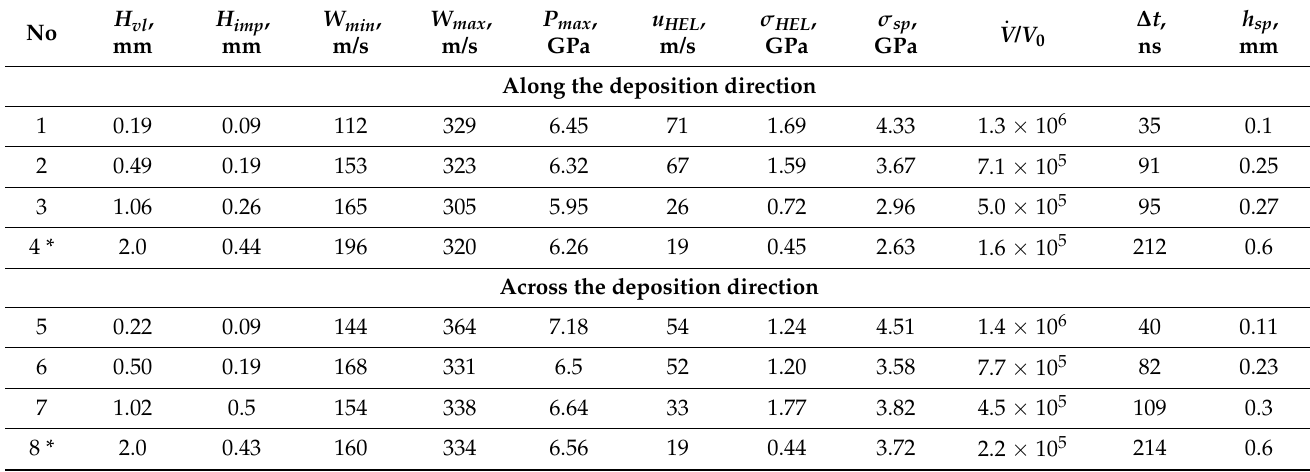
Table 1. The conditions and results of the experiments carried out with a PP50 pneumatic gun, and the results of wave profiles processing. Here h vl is the sample thickness; h imp is the thickness of the impactor; W min is the surface velocity before spalling; W max is the maximum surface velocity; P max is the maximum shock compression pressure; u HEL is the elastic precursor wave amplitude; σ HEL is the . V / V 0 is the strain rate in the rarefaction wave, ∆ t is Hugoniot elastic limit; σ sp is the spall strength; the time of a single spall pulse oscillation; h sp is the spall plate